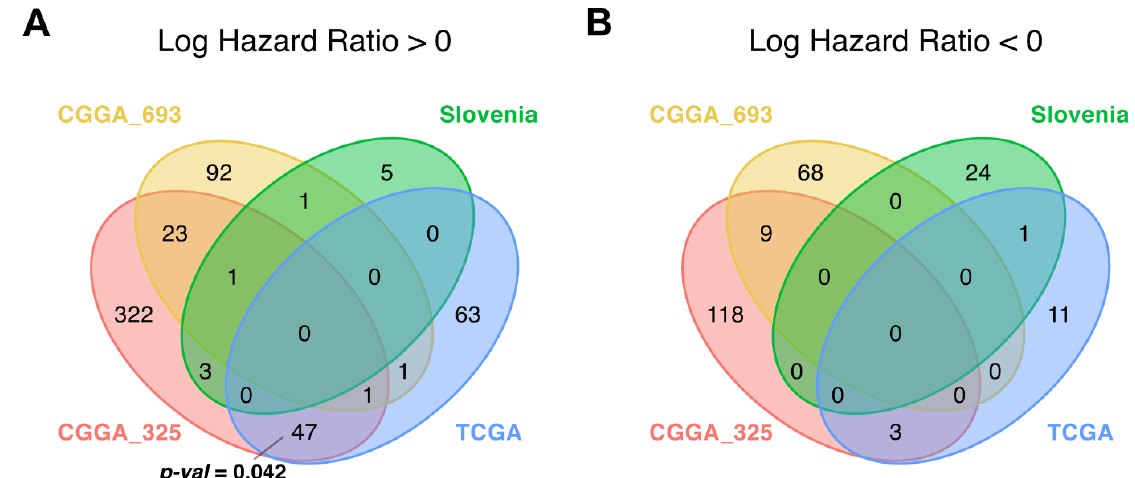
Figure 7. Intersections of differential ( A ) plus (hazard ratio > 0) and ( B ) minus (hazard ratio < 0) molecular pathways for overall survival (OS) analysis between CGGA_325, CGGA_693, TCGA and the experimental (Slovenia) glioblastoma expression datasets; p -values for intersection significance that are less than 0.05 are highlighted in bold.